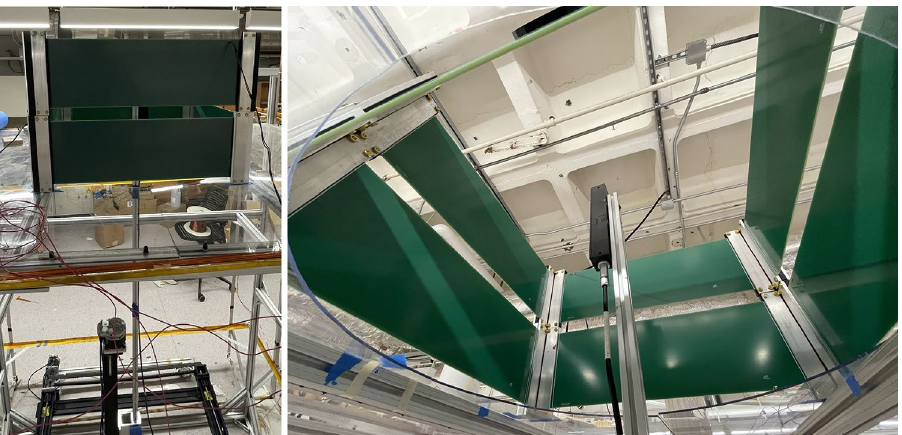
Figure 6. Setup of the experiment: Left: 3D magnetic field mapping system is sitting underneath the rectangular coils. Right: The triple-axis magnetometer and inside the